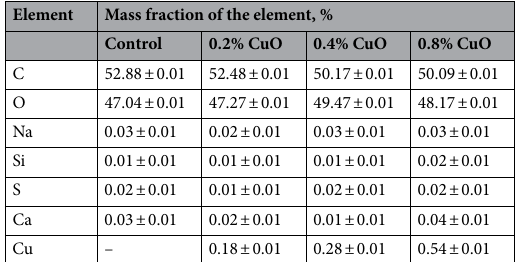
Element Mass fraction of the element,